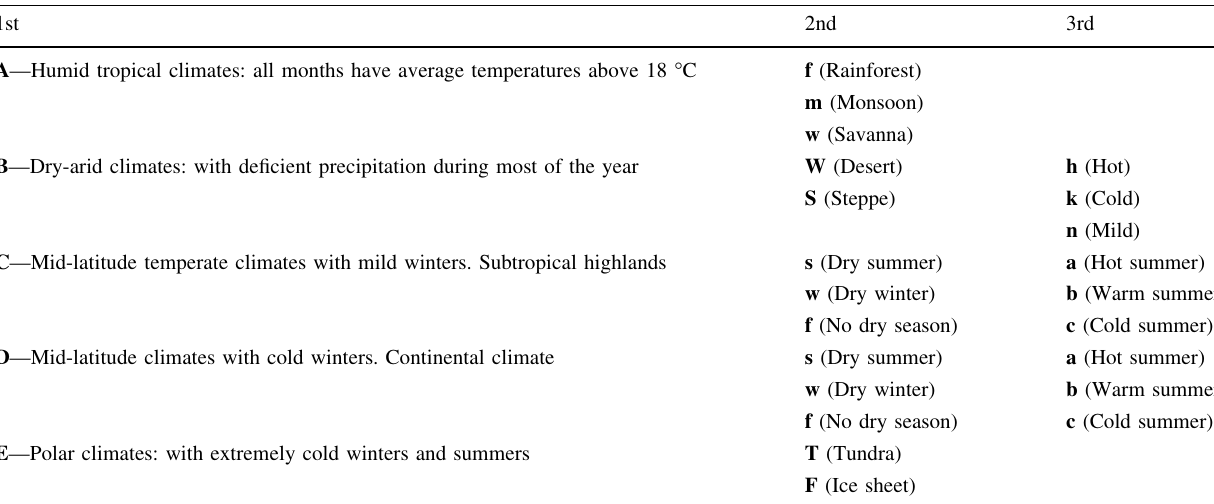
Table 1 Ko¨ppen climate classification scheme symbol description. Source : Adapted from Lutgens and Tarbuck